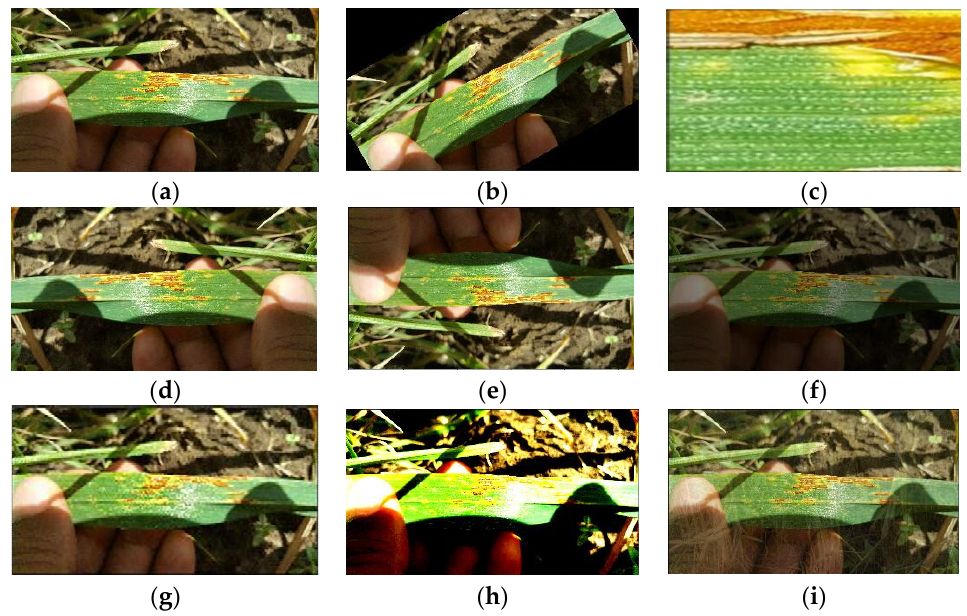
Figure 3. Comparison of the effects of 8 data enhancement methods. ( a ) Original image; ( b ) Rotated at any angle; ( c ) Randomly cropped and enlarged; ( d ) Horizontally flipped; ( e ) Vertically flipped; ( f ) Brightness enhanced; ( g ) Color dithered; ( h ) Contrast enhanced; ( i ) Mix-up enhancement.